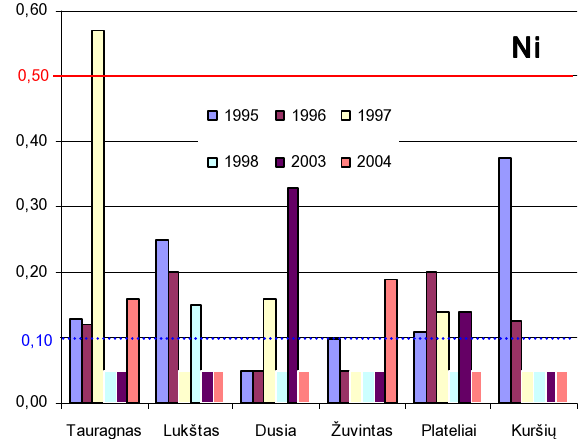
Ni Fig. 8. Dynamic of heavy metal (Ni) concentrations (mg/kg) in perch and roach muscles from monitored water Lyginant kontrolines ir paveiktas žuvų grupes nustaty- ta, kad chromo koncentracija paveiktų žuvų grupės